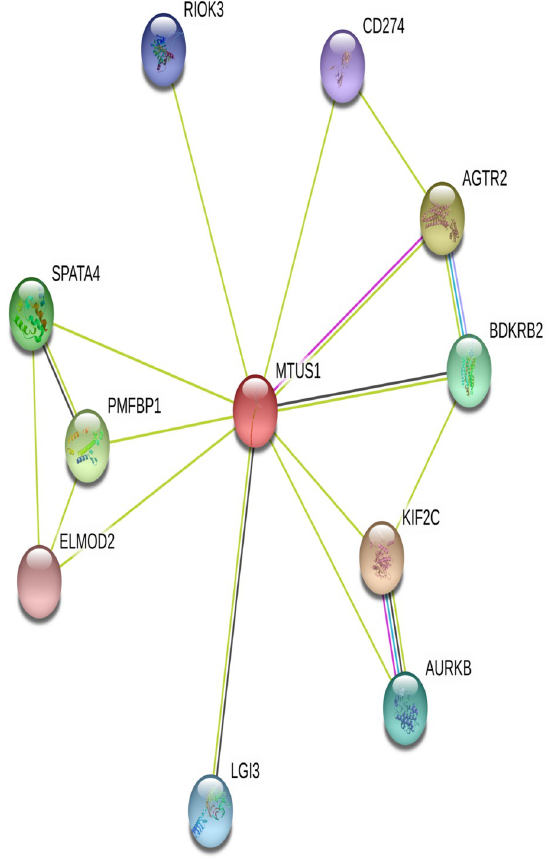
Fig 4. Protein–protein interaction network of MTUS1 using STRING server.